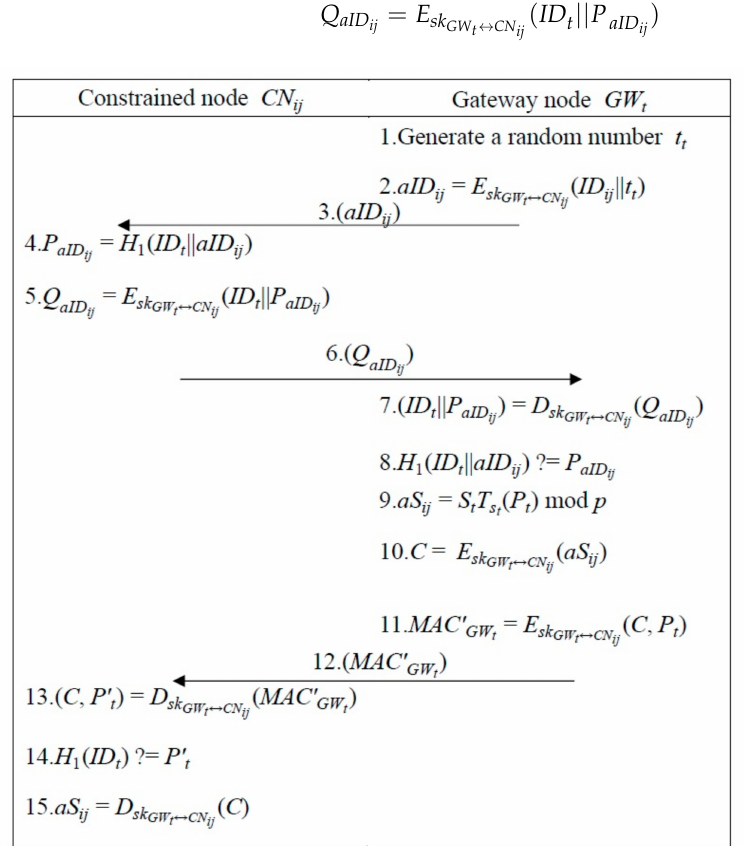
Figure 6. Anonymous identity distribution phase of proposed